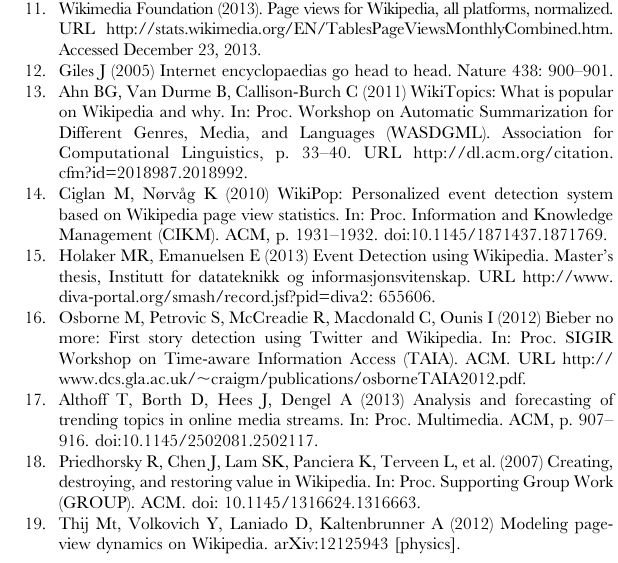
This table lists the transferability scores r t for each tested pair of countries within a disease. Countries that did not share enough articles to compute a meaningful r t are indicated with n/a